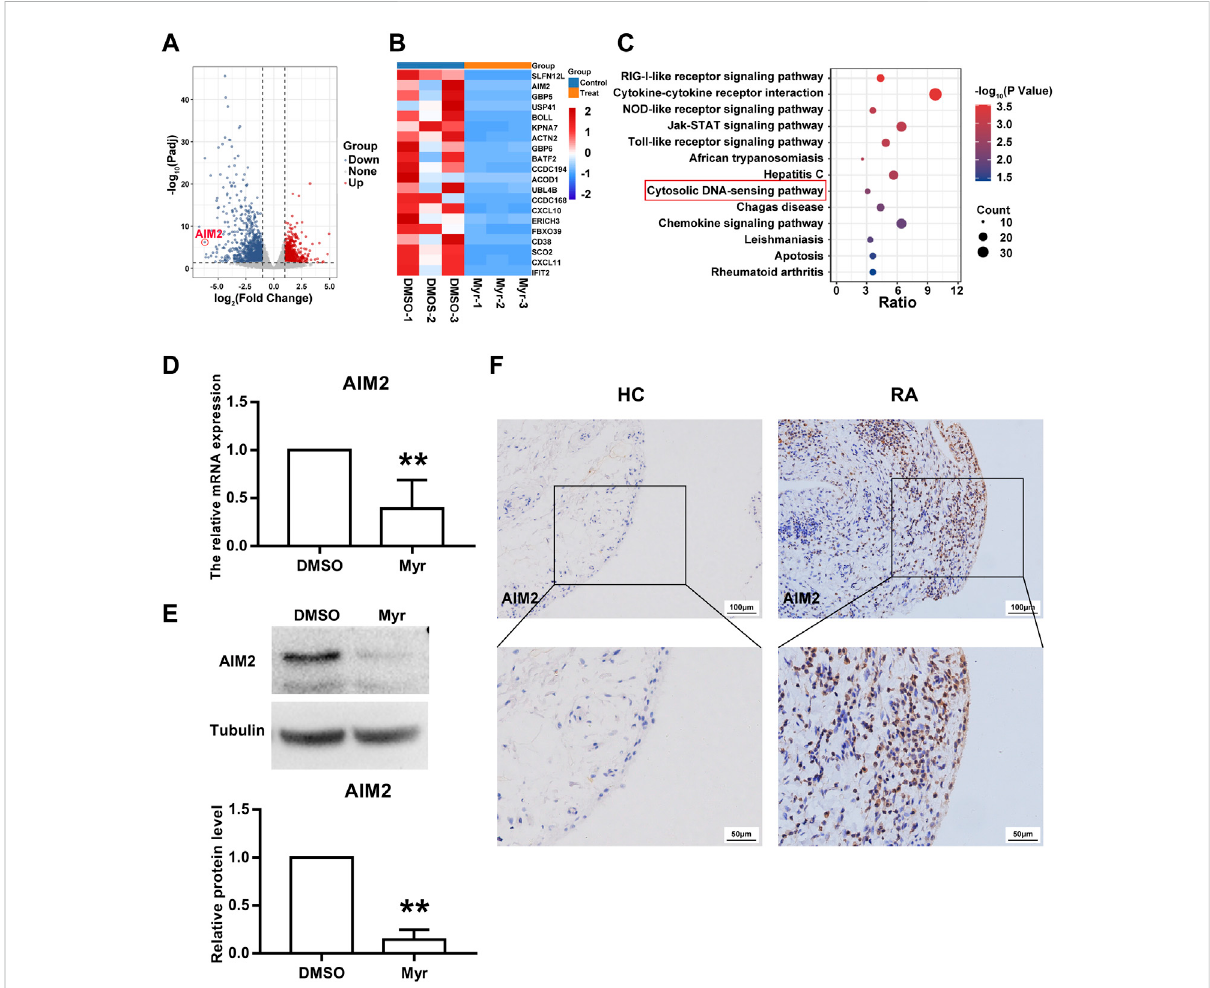
FIGURE 3 AIM2 is identi fi ed as a target of Myr. (A) Volcano plot indicated up-regulated and down-regulated gene (Padj < 0.05 and |log 2 FC| > 1) by RNA sequencinginMyr-treatedversusDMSO-treatedRAFLSsfrom3patients. (B) Heatmapofthetop20differentiallyexpressedgenes(DEGs). (C) Bubble plot of the top 13 enriched KEGG pathways of DEGs. (D,E) Myr downregulated the gene and protein expression of AIM2 by using RT-qPCR (D) and Westernblot (E) .Dataarepresentedasthemean±SDfromatleast3independentexperiments. (F)